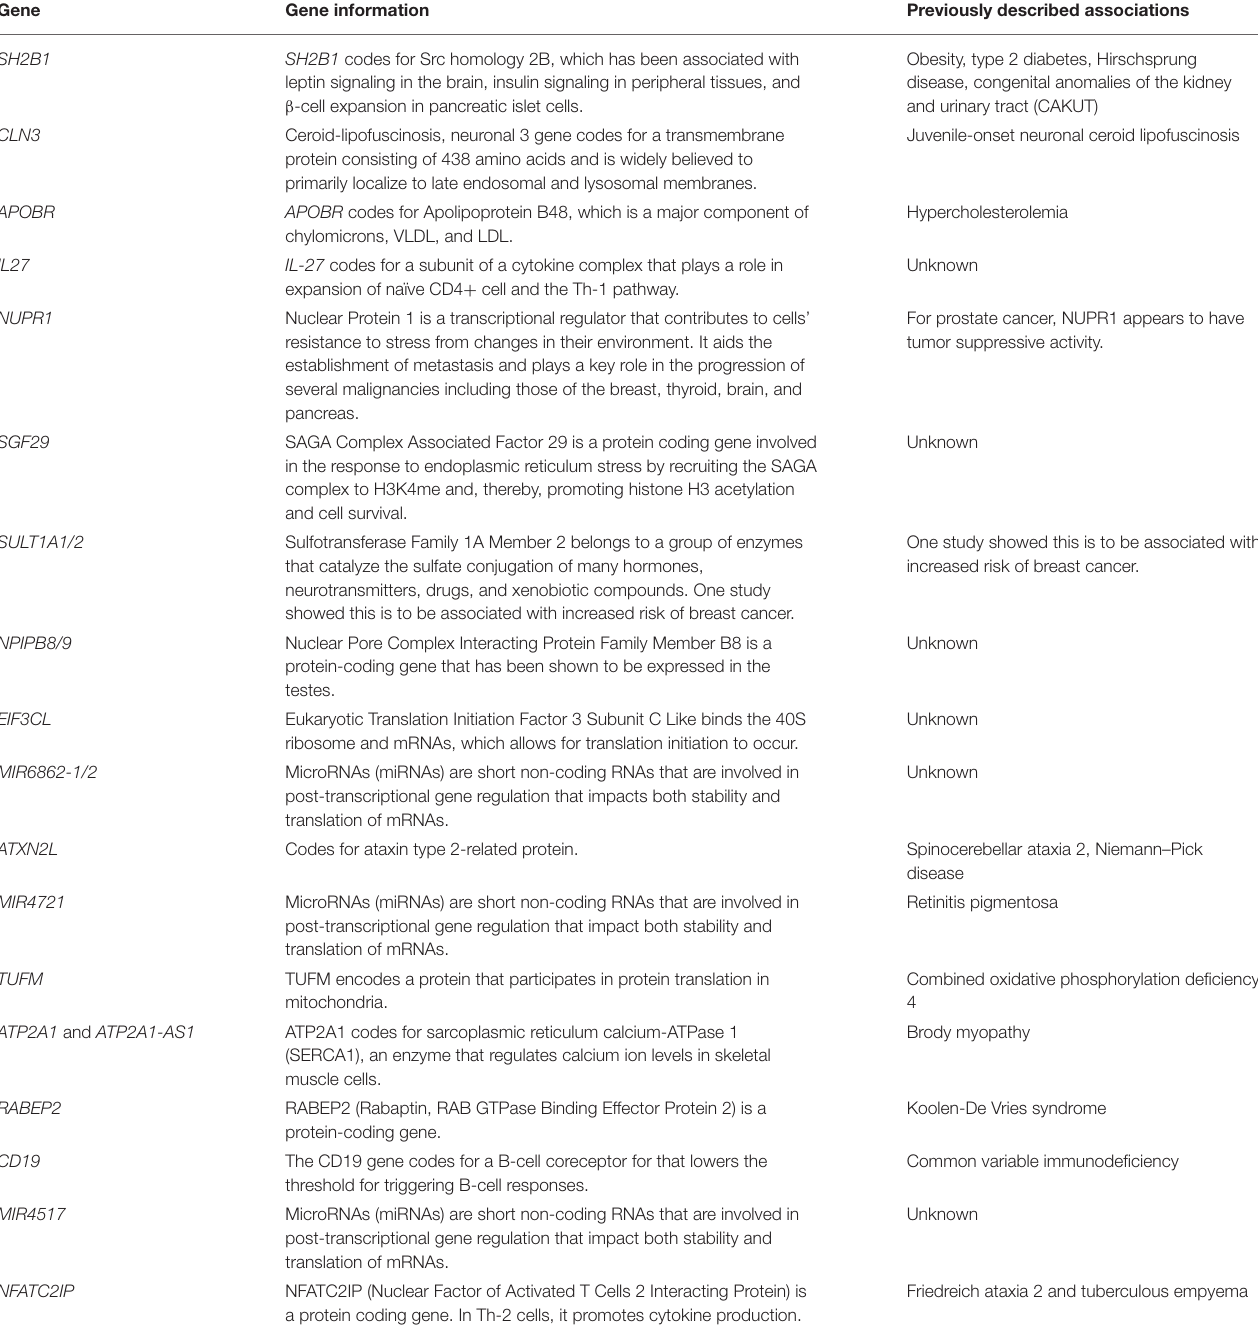
TABLE 1 | Genes included in the 16p11.2 duplication